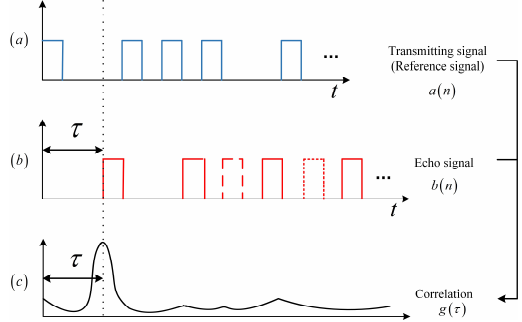
Figure 4. The schematic diagram of the true random coding photon counting LIDAR ranging principle. ( a ) Transmitting signal a ( n ) . ( b ) Echo Signal b ( n ) . ( c ) Correlation function g ( τ )